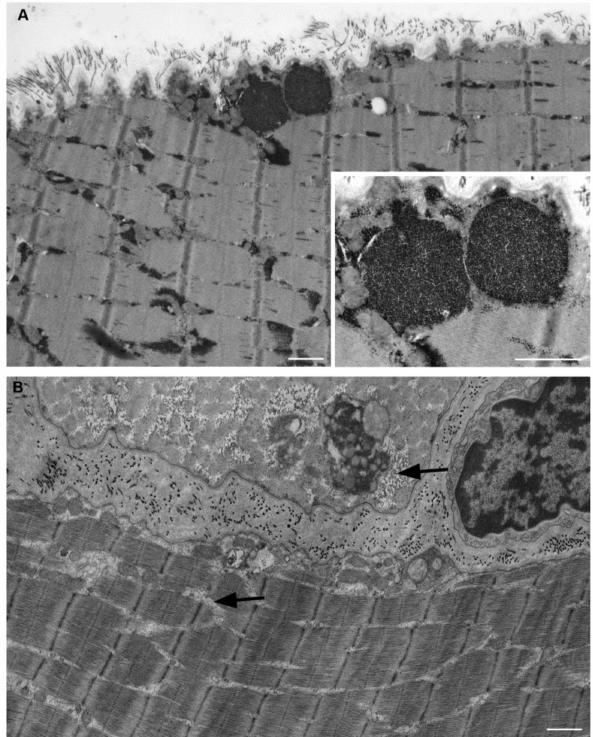
Figure 1. Electron microscopy of muscle fibers in longitudinal section of a patient with Pompe disease. ( A ) Pre-treatment muscle fiber. Two glycogen-filled lysosomes under sarcolemma are enlarged in the inset. Massive glycogen accumulations are also present within intermyofibrillar spaces. ( B ) Post treatment muscle fiber shows relevant glycogen reduction. A low amount of glycogen granules (arrows) still appears located within some intermyofibrillar spaces. Scale bar = 1 µ m. Inset scale bar = 0.5 µ